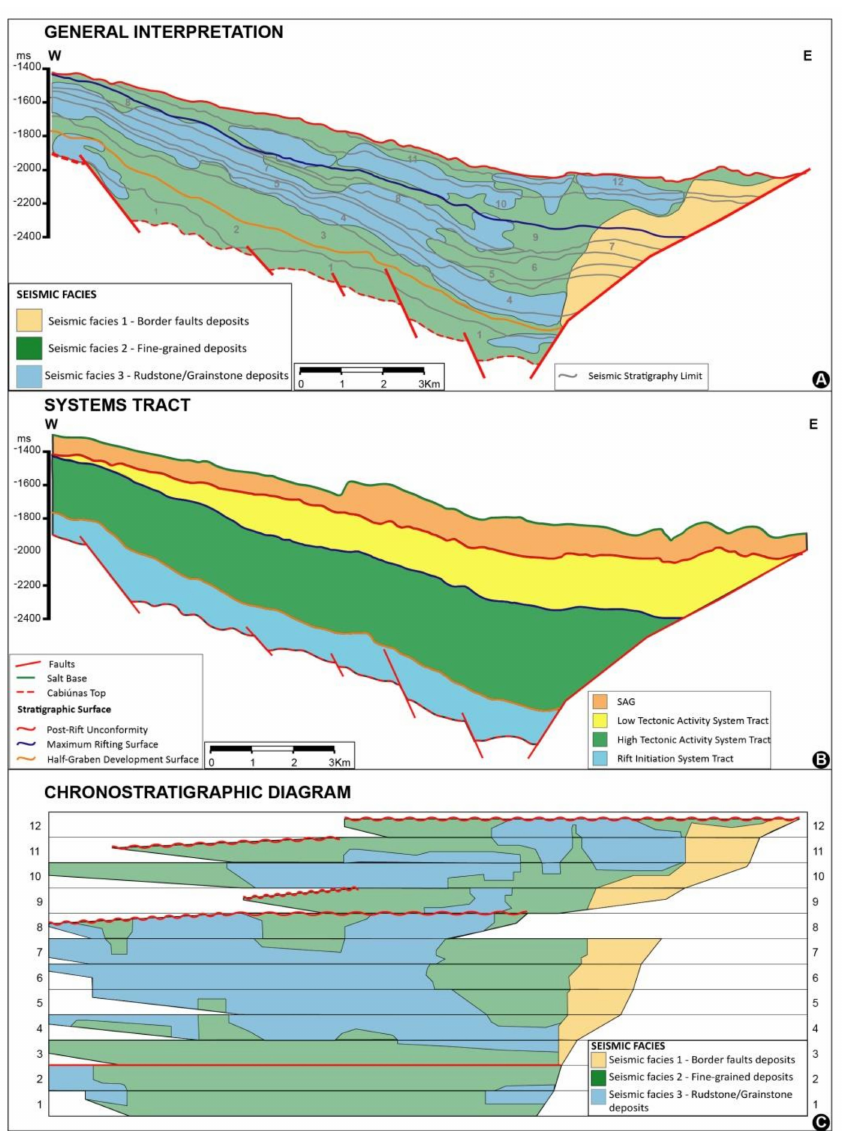
Figure 7. Seismic line L3 (Figure 1B). ( A ) Integrated interpretation with seismofacies, seismic strati- graphic units and surfaces. ( B ) Delimitation and interpretation of systems tracts. ( C ) Chronostrati- graphic